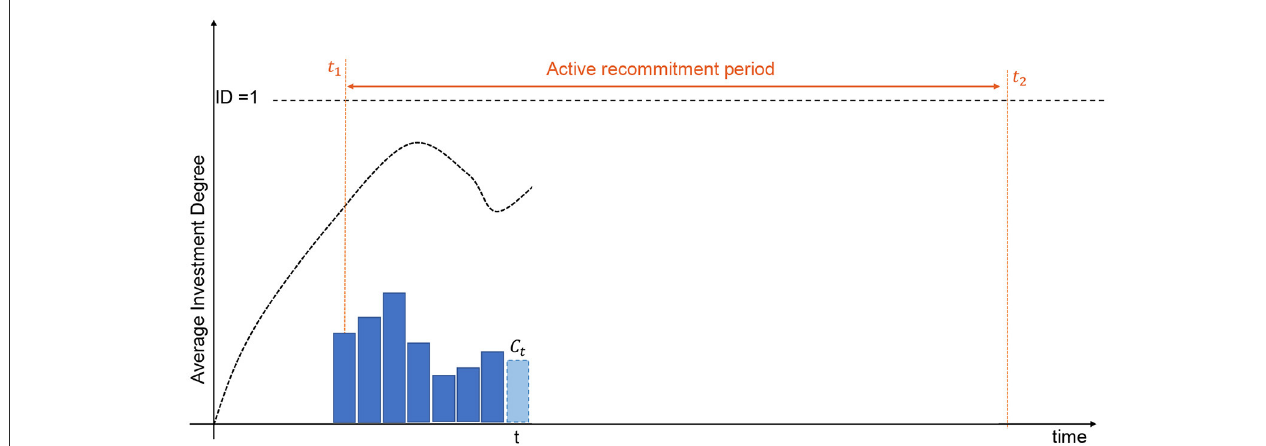
FIGURE7 Simulation of private equity portfolios.